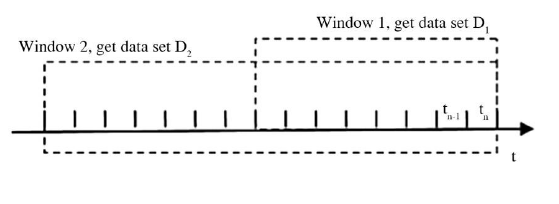
Fig. 3 Time series based on windowing